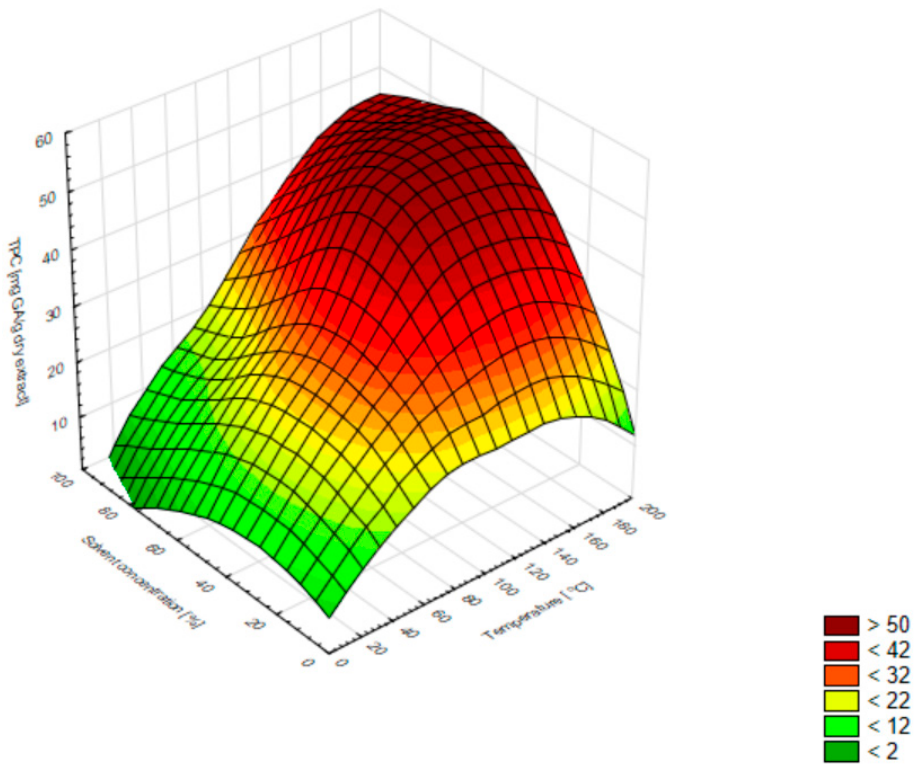
Figure 1. Three-dimensional surface chart of the total phenolic content vs. temperature and solvent concentrations for all extraction methods (smoothing of the smallest squares weighted by distance).